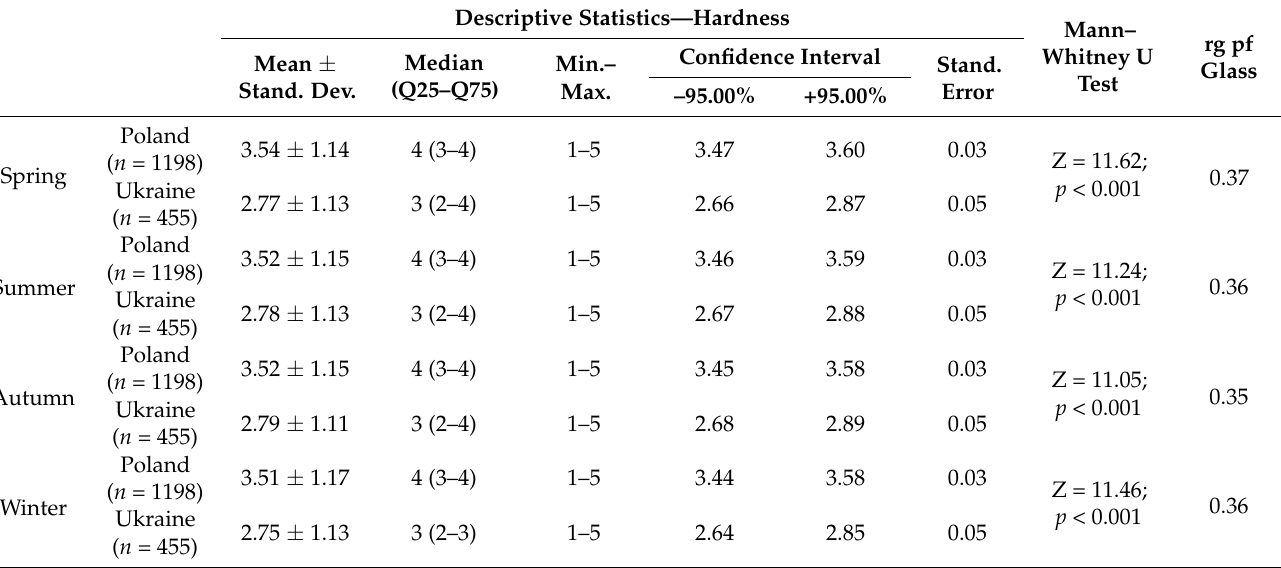
Mann– rg pf Whitney U Test